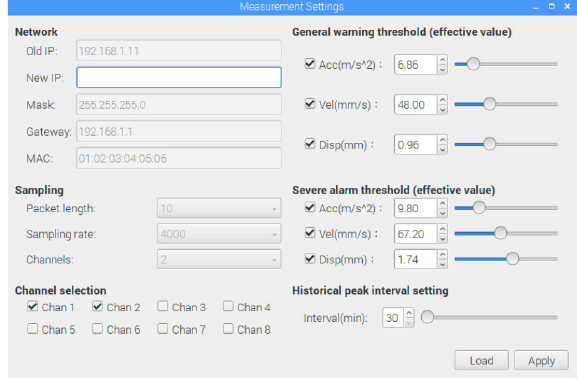
Figure 5. Measurement settings